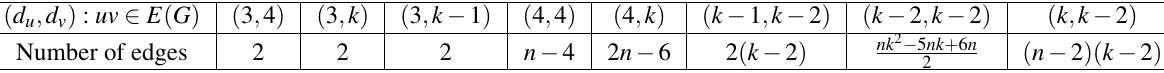
Table 3 The size partition of G